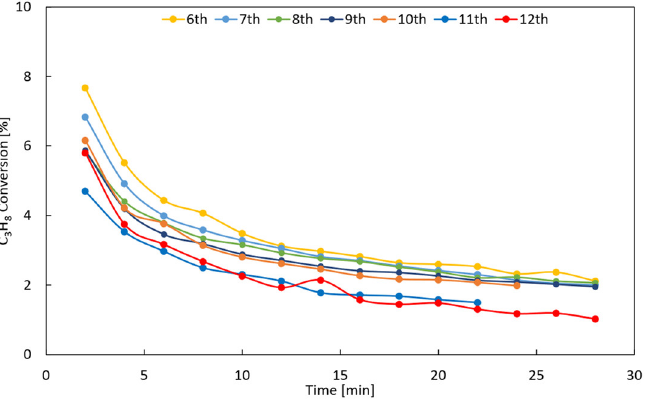
Figure A7. Propane conversion versus time for each reactive cycle performed for the catalyst stabilization (for larger amount of cycles).